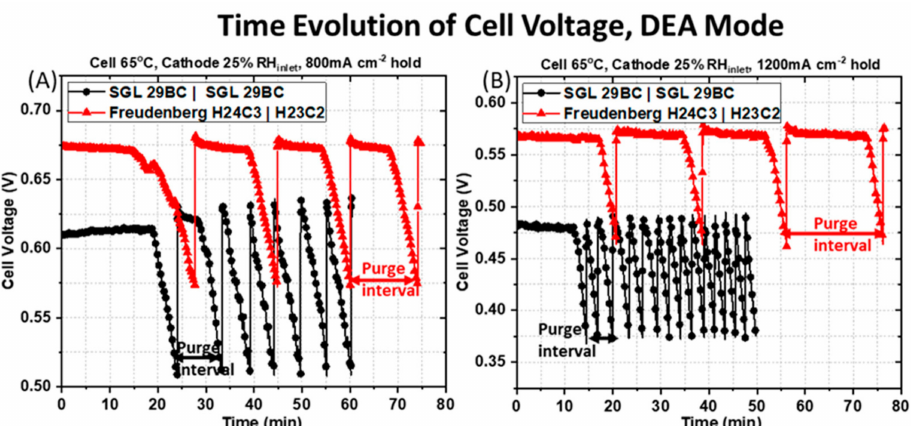
Figure 6. Time evolution of the cell voltage obtained at applied current densities of ( A ) 800 mA cm − 2 and ( B ) 1200 mA cm − 2 for an H 2 inlet pressure of 2 psi and 25% RH inlet cathode. The purge interval is defined as the time between each valve opening event; examples of a purge interval are depicted by the black and red arrows at the bottom of the